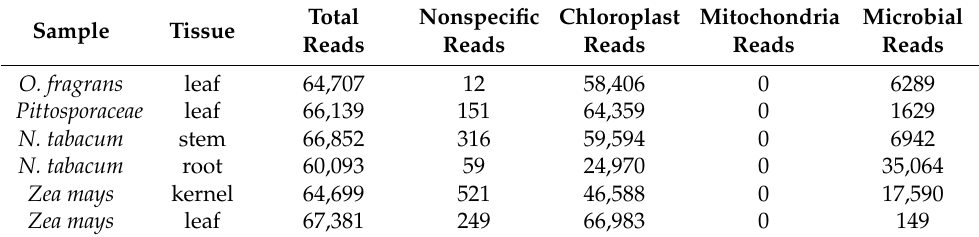
Table 3. Sequence information from 16S rDNA amplicon